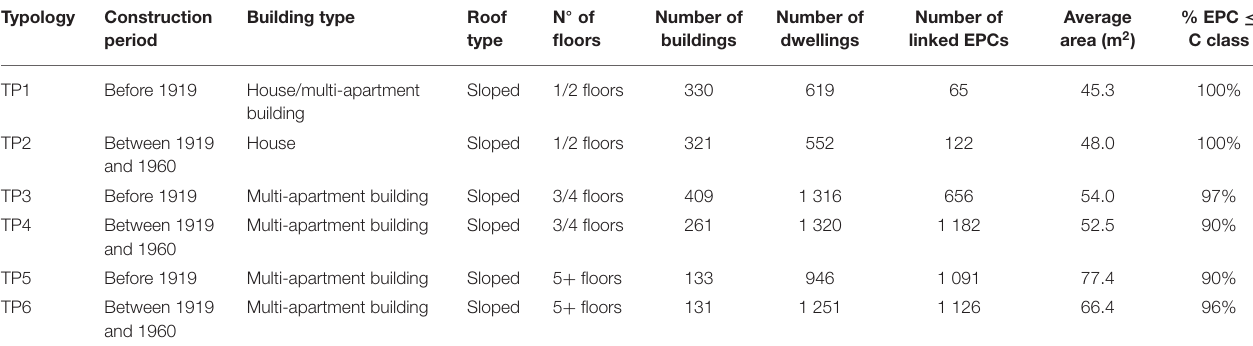
TABLE 1 | Main characteristics of the representative residential building typologies for Alfama